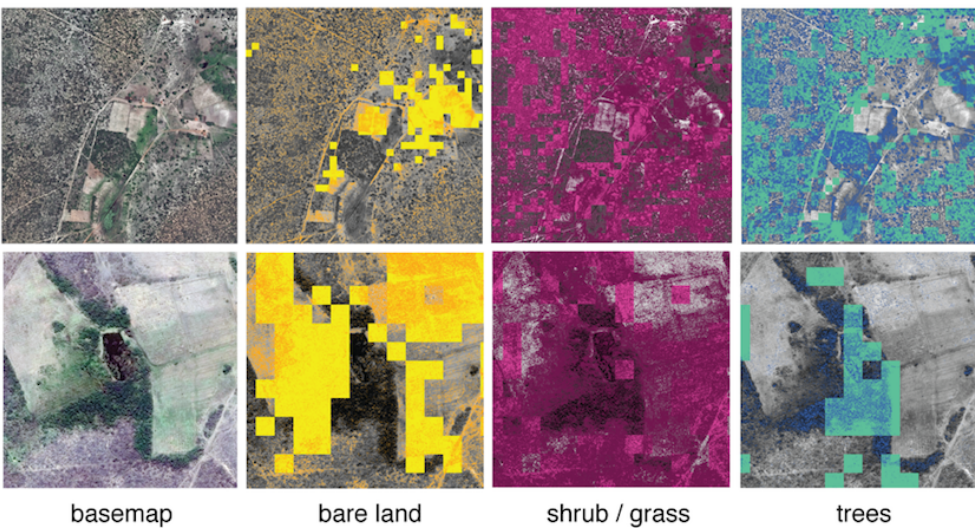
Figure 8. Full ecosystem landcover classification examples using 3-class classifiers with WorldView and Landsat data. The top row shows a 1 km × 1 km section of one of the ten test regions (the same area shown in Figure 1); the bottom row shows a 380 m × 380 m region (to show greater detail). The first column shows the WorldView imagery in RGB color; the other columns show the classifier results for WorldView and Landsat 8 data, separated by class. In each case, the lighter color shows the Landsat pixel classification overlaid on the Worldview Imagery, and the darker color shows the WorldView classification. WorldView imagery in columns 2–4 is shown in grayscale for clarity. Full classification results of the 10 areas (1000 km 2 ) can be found at https://goo.gl/8fEj4r (see supplementary